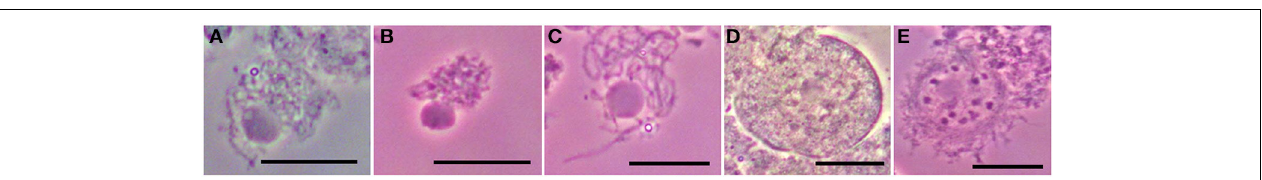
FIGURE 2 | Chromosome spreads of rice meiocytes in prophase I counterstained with carmine:acetic acid. (A) Leptotene. (B) Zygotene. (C) Paquitene. (D) Diplotene. (E) Diakinesis. The nucleolus is visible during all prophase I. Bar = 20 μ m.